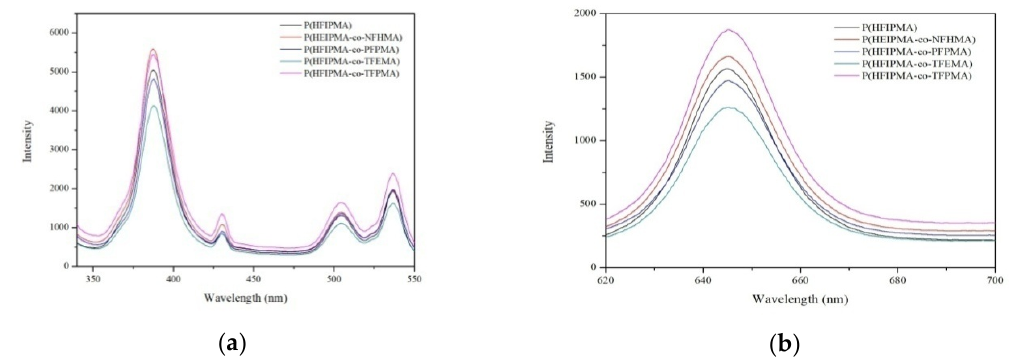
Figure 3. ( a ) The excitation spectra and ( b ) the emission spectra of individual polymer/PtTFPP films in N 2 environment.